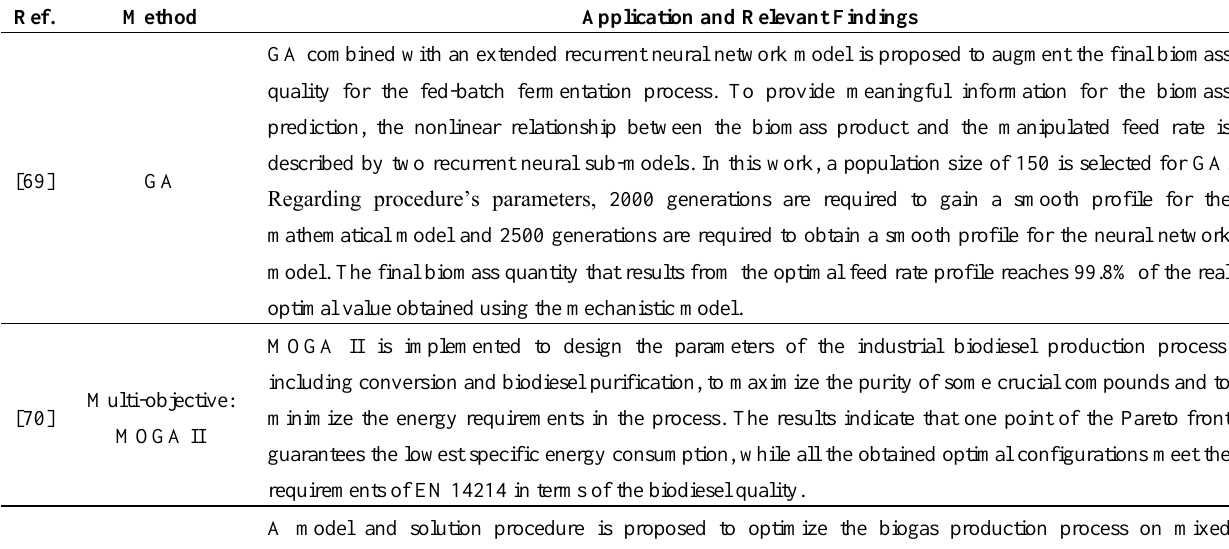
Table 7. Reviewed articles in the bioconversion and production process optimization category.